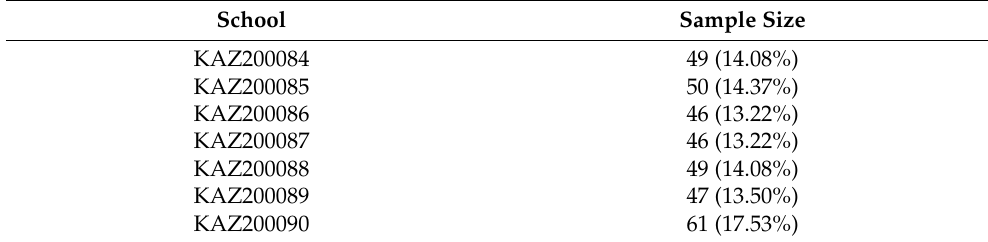
Table 2. Sample sizes of parents from different schools.